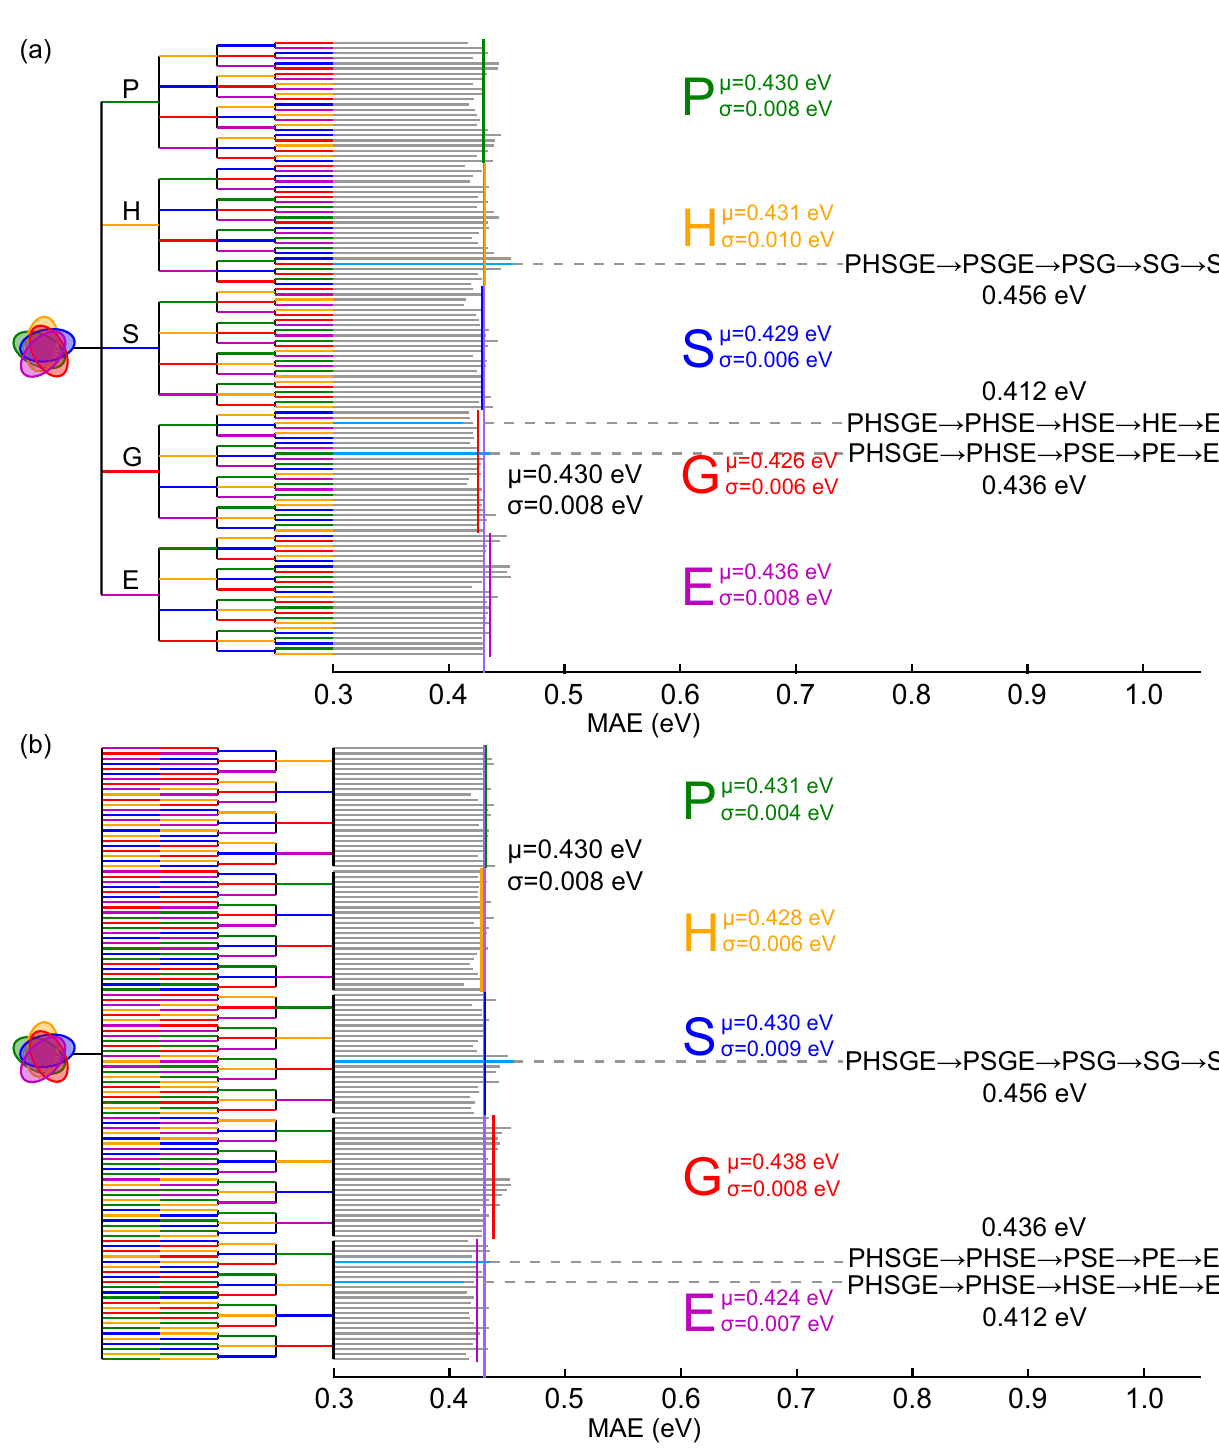
Fig. 8 MAE results on the cleaned data using the onion training approach. All possible dataset sequences are gathered a according to the fi rst dataset used and b following the last dataset used. The data was cleaned using the best model of Fig. 6. The global average of the MAE is shown by a vertical solid purple line ( μ = 0.430 eV), while the group averages are indicated by their corresponding color (P in green, H in orange, S in blue, G in red, and E in magenta). The corresponding standard deviations ( σ ) are also indicated accordingly. The best and worst training sequences, as well as the worst one ending by E, are highlighted in light blue. The training sequences that produce NaN for one of the folds (so the MAE is only that of the other fold) are indicated by a lighter gray bar, while those that lead to NaN for both folds are left